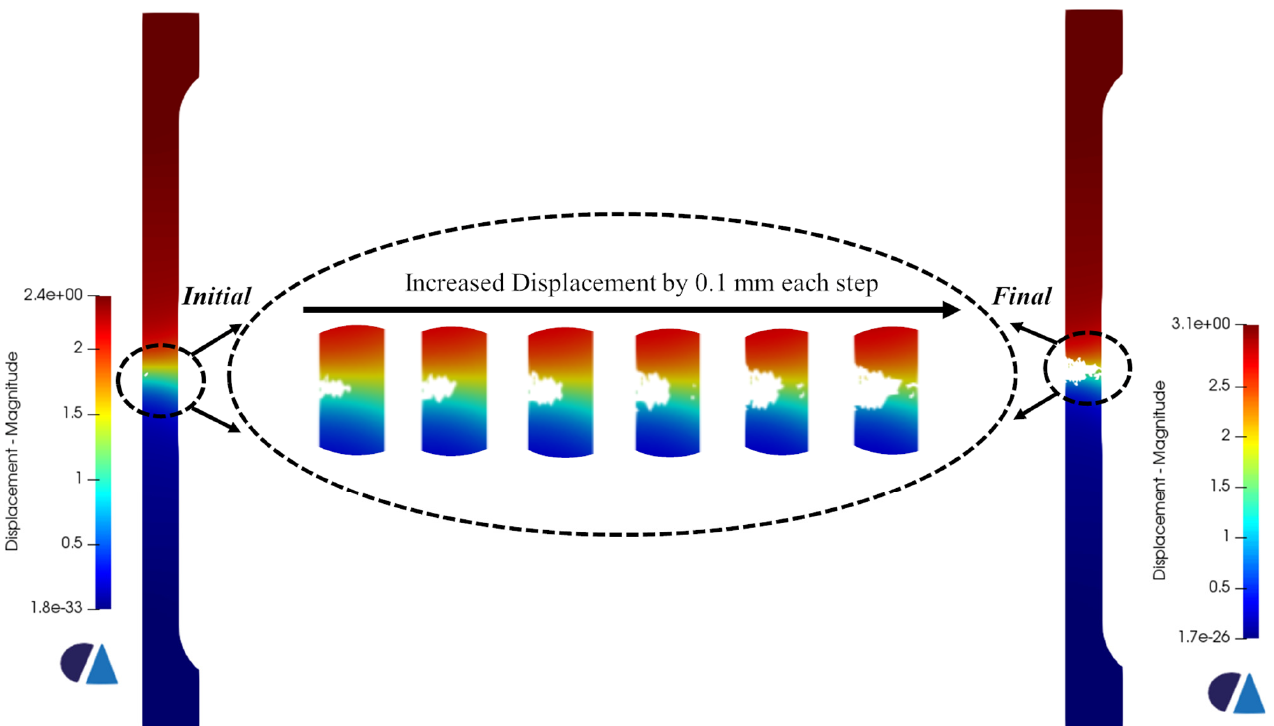
Figure 8. Fracture and failure progression in the round bar with an incremental increase in displace- ment. The displacement values are in mm.